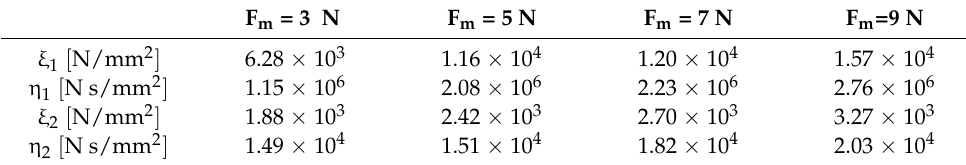
Table 3. Model constants when fitted to data from the individual load